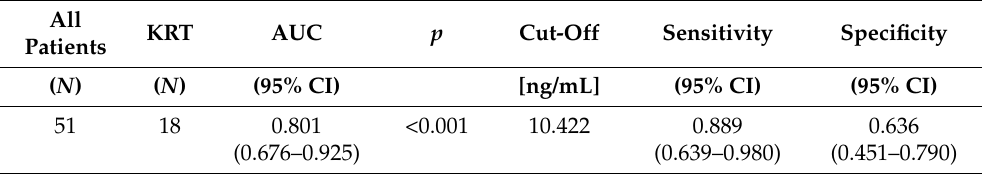
Table 2. The receiver operating characteristic analysis for predicting kidney replacement therapy (KRT) based on the suPAR level.